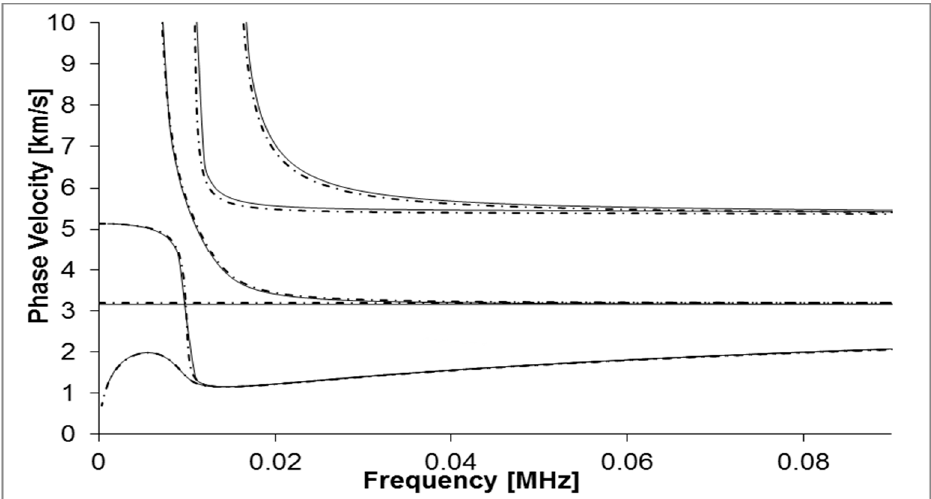
Figure 1. Dispersion curve for 6-inch schedule 40 carbon steel pipe cross section using DISPERSE software (solid lines) and GUIGUW software (dashed lines).